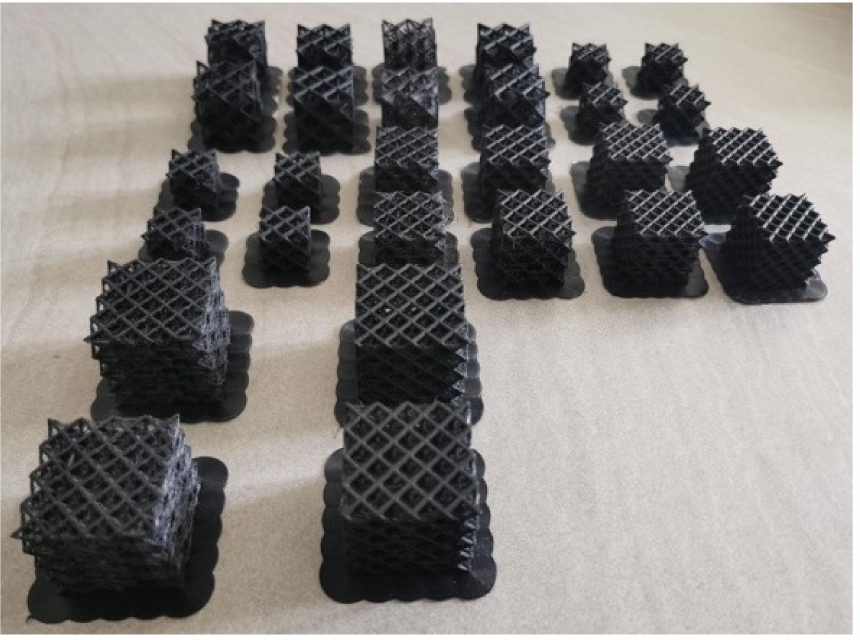
Figure 2. Twenty-eight out of 48 carbon nylon specimens for the compression